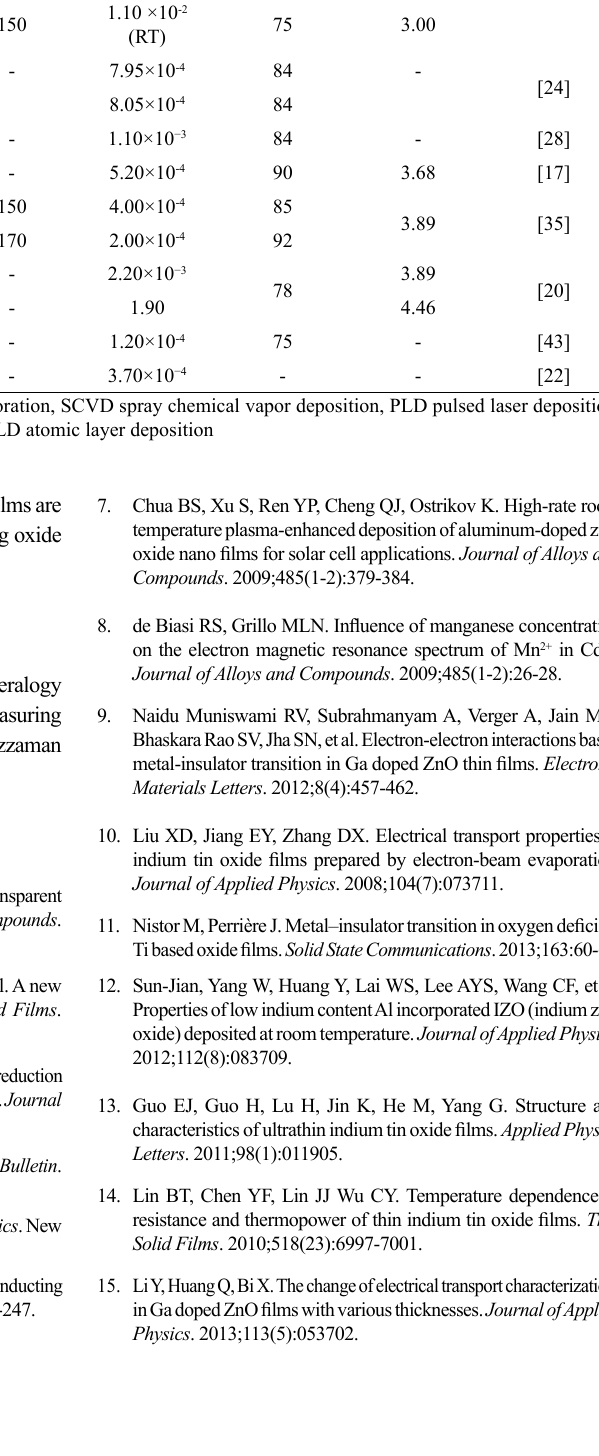
Table 3: Comparison of electrical and optical properties of V: In various techniques. Technique